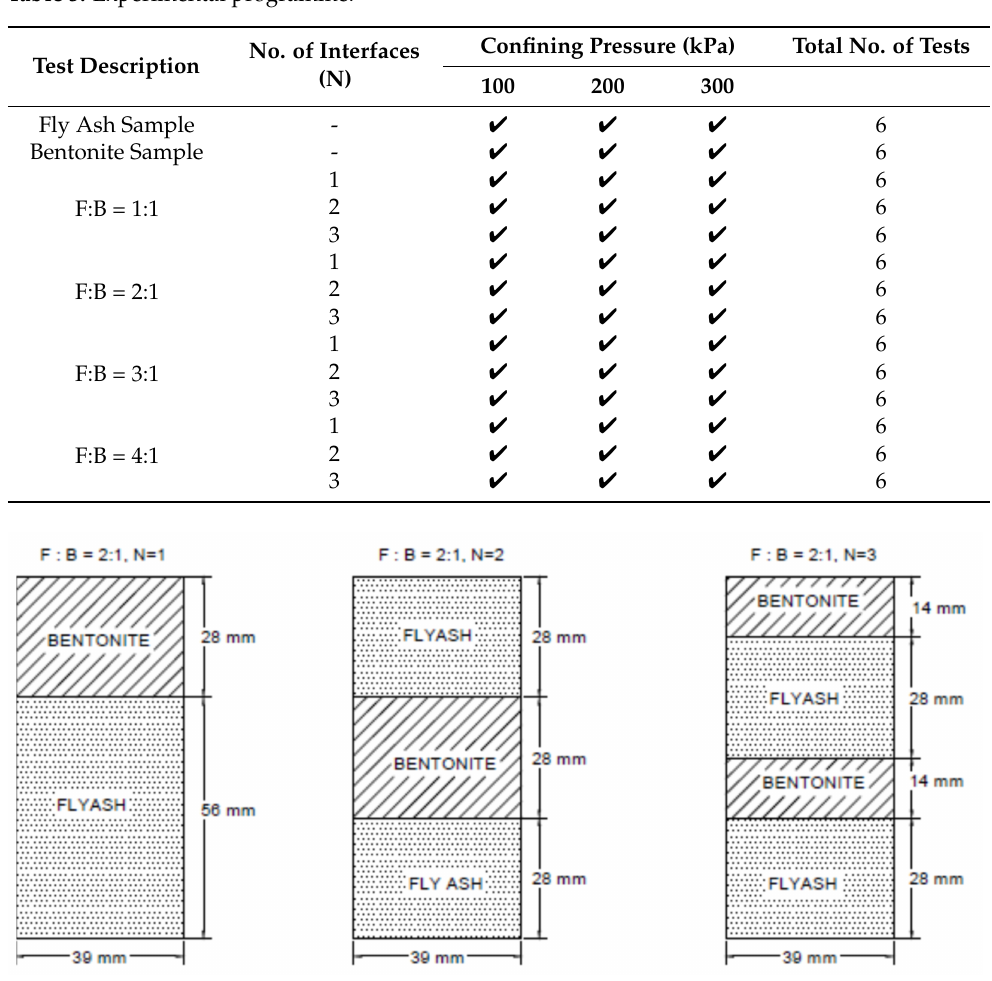
Table 3. Experimental programme.